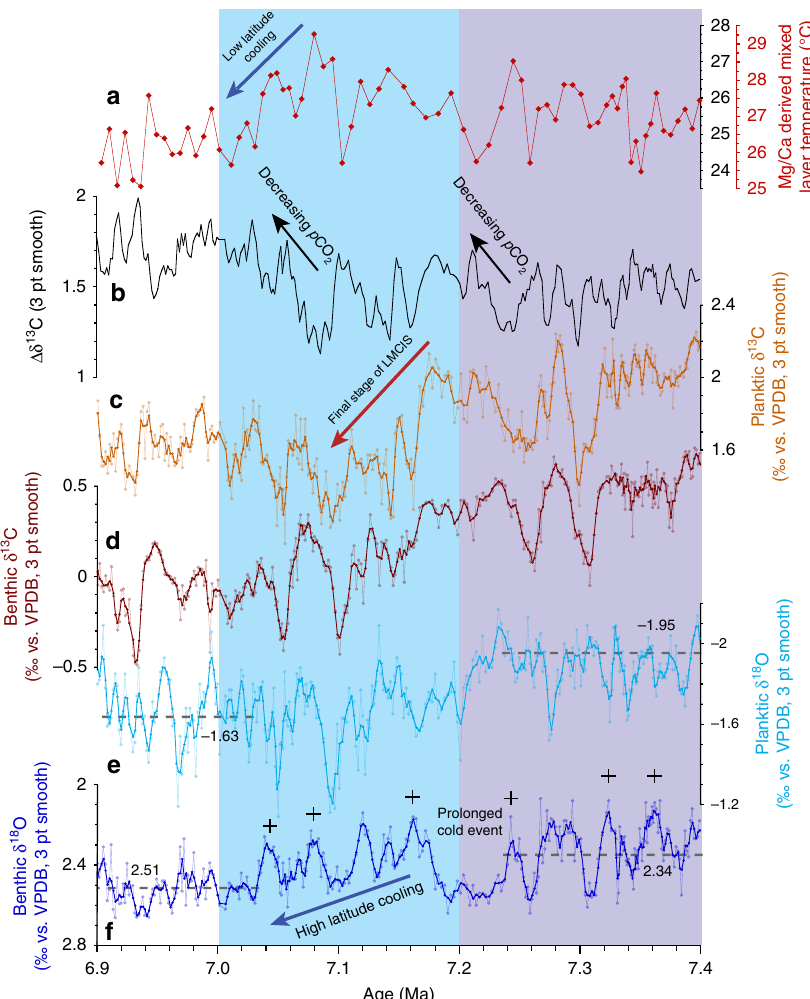
Fig. 4 Expanded view of interval 7.4 – 6.9 Ma at ODP Site 1146. a Mg/Ca-derived mixed layer temperatures with (red scale) and without (black scale) correction for secular changes in Mg/Ca of seawater. b Δ δ 13 C; c Planktic δ 13 C. d Benthic δ 13 C. e Planktic δ 18 O. f Benthic δ 18 O. Dashed horizontal lines indicate long-term mean of planktic and benthic foraminiferal δ 18 O for intervals 5.07 – 7.03 Ma ( n = 1114 and 1015) and 7.23 – 8.00 Ma ( n = 454 and 446). Lilac shading marks global δ 13 C decline coincident with planktic δ 18 O increase and high-amplitude obliquity modulation of benthic δ 18 O. Blue shading marks fi nal stage of global δ 13 C decline. Age correlation points are indicated by crosses; 3 pt smooth: 3 pt moving